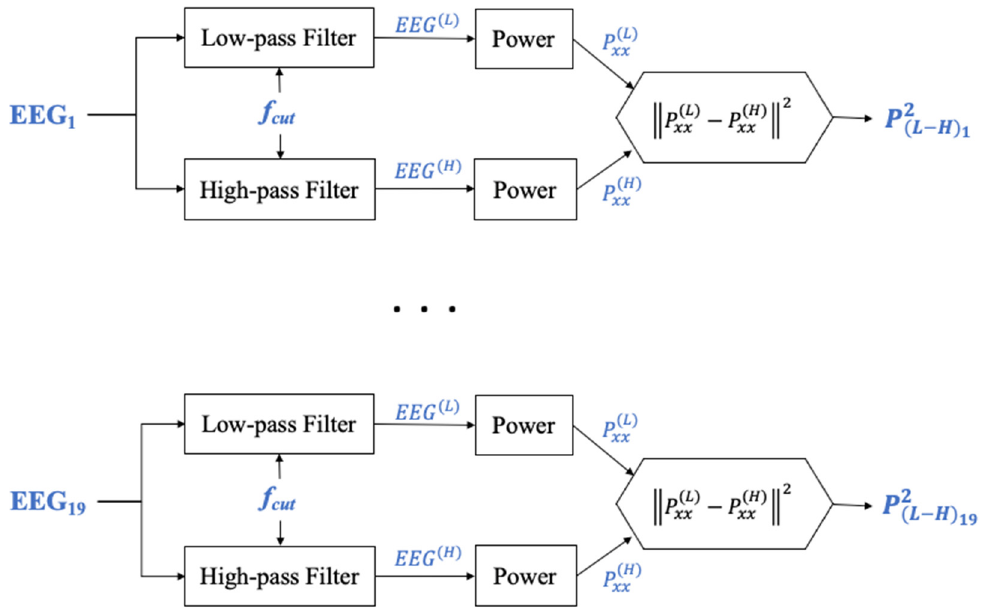
Figure 1. Schematic representation of the double filtering method. The initial input is the subsequence of the main EEG signal, which is divided and filtered according to the two main branches. The final result is the square of the power absolute difference. The block “Power” is explained in Appendix A. Table 1. Schema of the feature extraction procedure: features extracted from an EEG recording are shown in the last